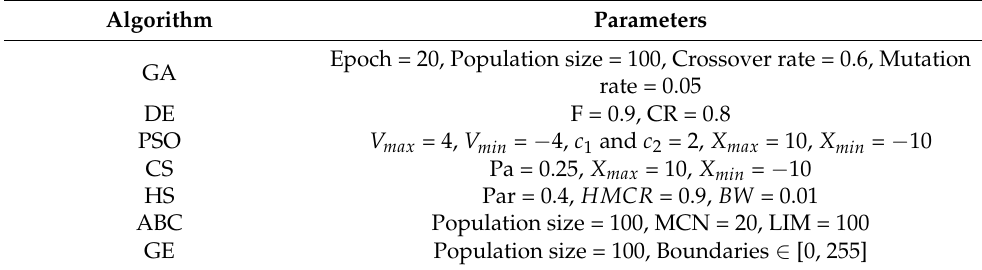
Table 3. Specific parameters of the metaheuristic algorithms.